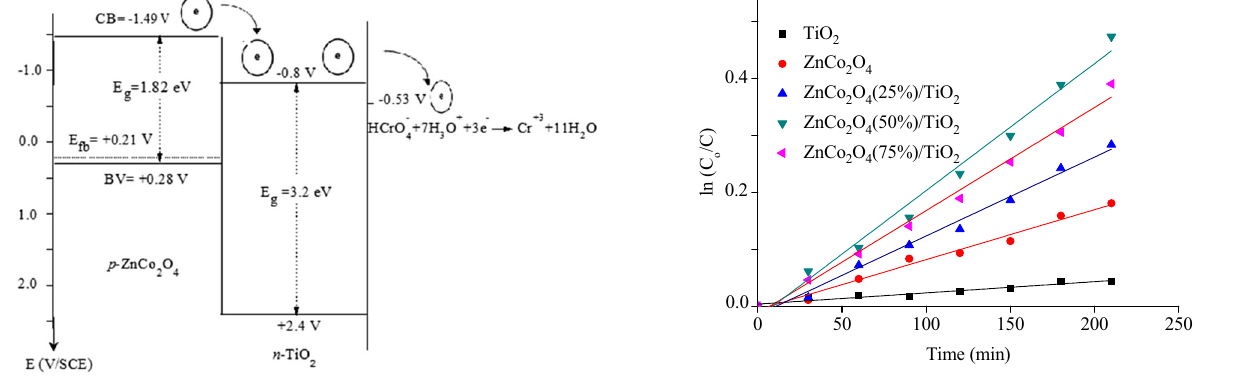
Fig. 6 The energy band diagram of ZnCo tion of the photoelectrochemical cell